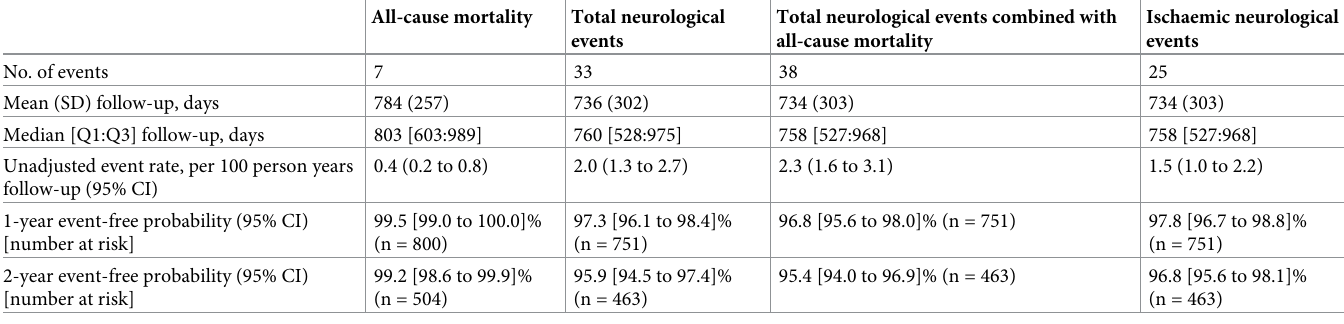
Table 3. Longitudinal outcomes: All-cause mortality, neurological events and composite outcome from linked data (registry and HES).